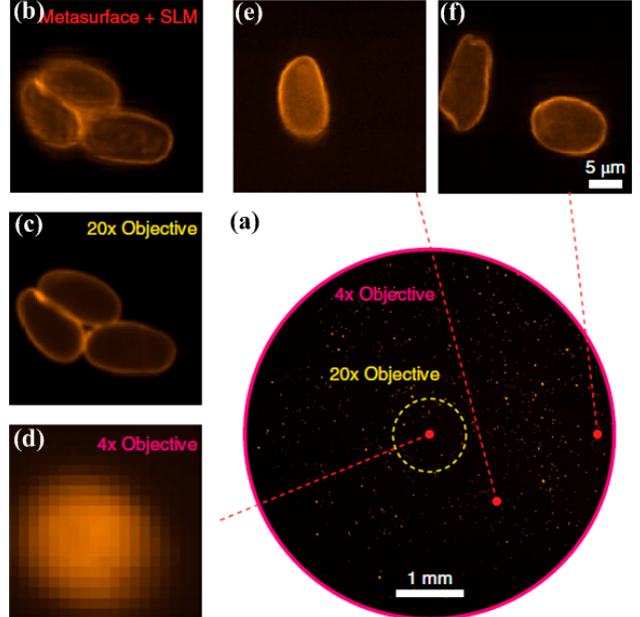
Figure 9. ( a ) Low-resolution image captured by a conventional fluorescence microscope with a 4 × objective lens. ( b ) Scanned image obtained with a disordered metalens. ( c ) Ground-truth fluorescence image captured with a 20 × objective lens. ( d ) Magnified low-resolution fluorescence image captured with a 4 × objective lens. ( e , f ) Images obtained with the disorder-metalens assisted microscope at (x, y) = (1, 1) and (2.5, 0) mm, respectively. Reproduced with permission from [132]. Copyright